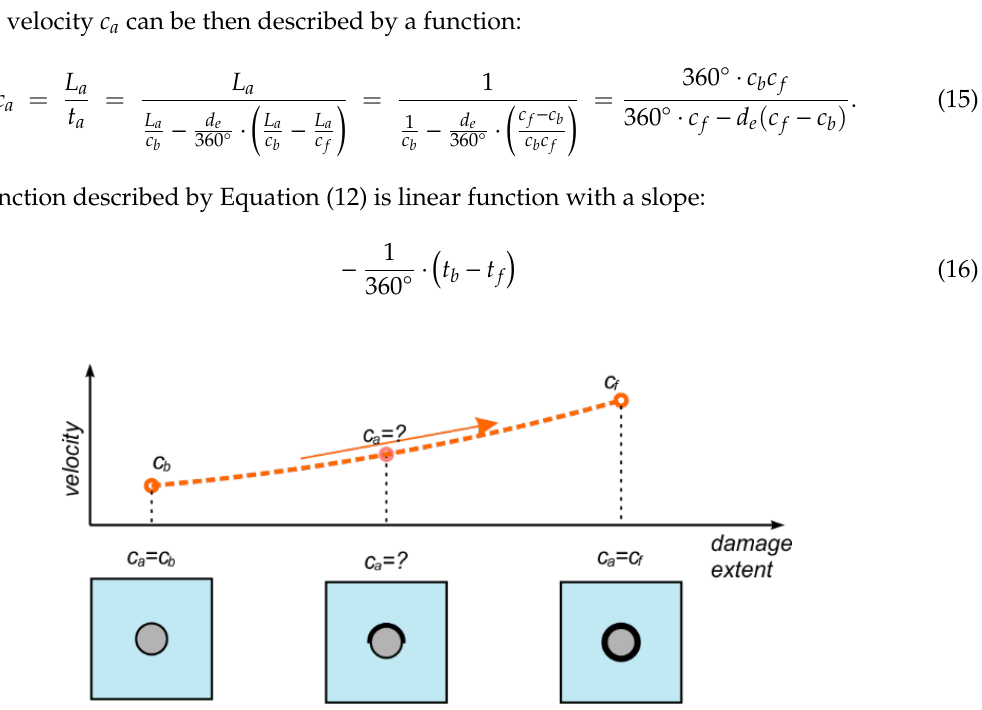
Figure 9. Changes in an average wave velocity depending on debonding size.